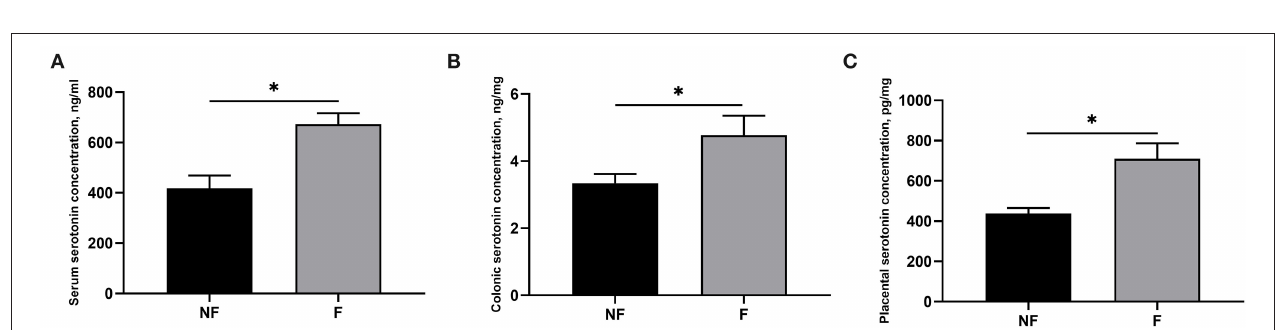
FIGURE 2 | Effects of fiber supplementation in gestation diet on serotonin concentrations in serum, colon, and placenta of the sow. (A) Serum serotonin; (B) Colonic serotonin; (C) Placental serotonin. NF, sows fed with a semi-purified basal diet (0.01% dietary fiber); F, sows fed with a semi-purified basal diet supplemented with 8.33 g/kg inulin and 200 g/kg cellulose. Values are mean ± standard error ( n = 5). Significant differences are displayed in the figures by * P < 0.05.